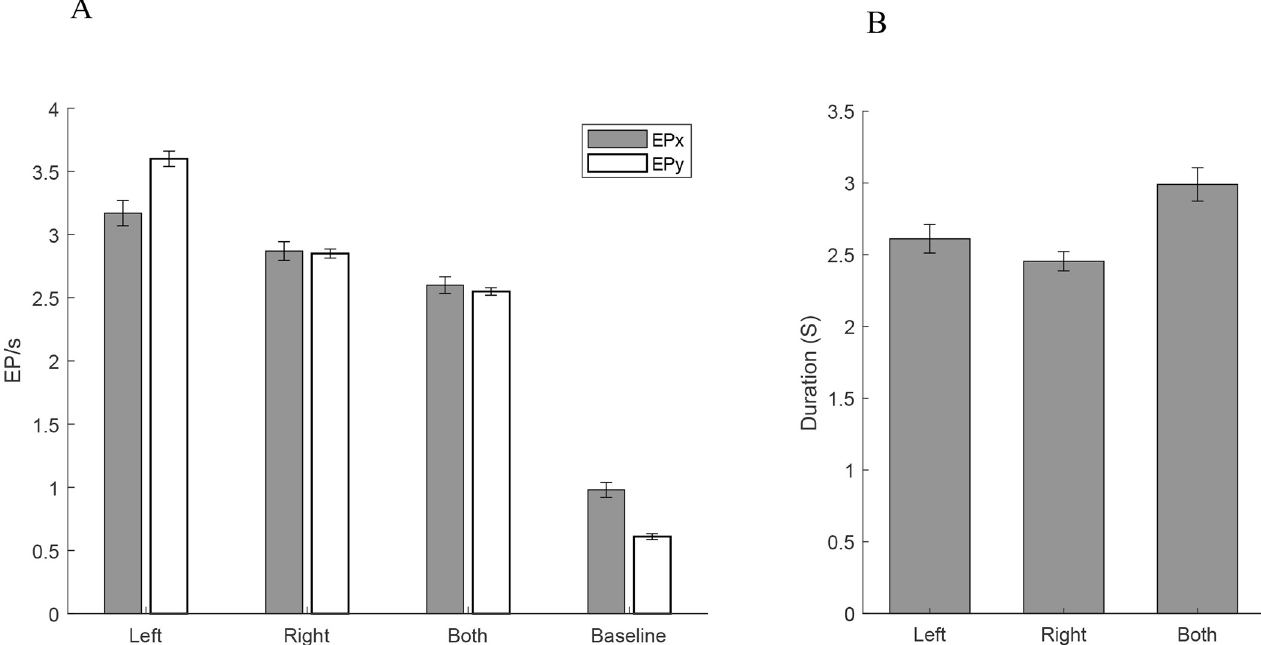
Fig 4. (A) Density of Equilibrium points in the AP and ML directions. Leftward perturbation (stimulation of the left side) caused a higher density of EPs in the perturbation phase. This was statistically significantly higher than the bilateral stimulation condition. Statistically significant differences were found between left and right side stimulation for both EPx and EPy and between left and bilateral stimulation. (B) Duration of perturbation. The error bars are Standard Error of the Means.